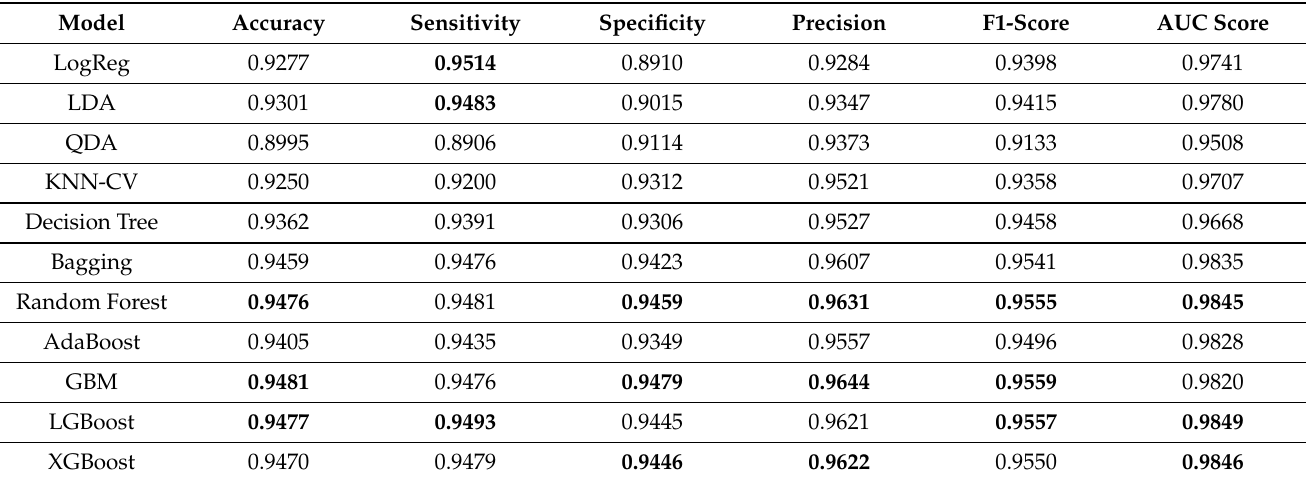
Table 4. Results for all models with 10-s segmentation scheme using LOOCV. Top three results are highlighted for each measurement.